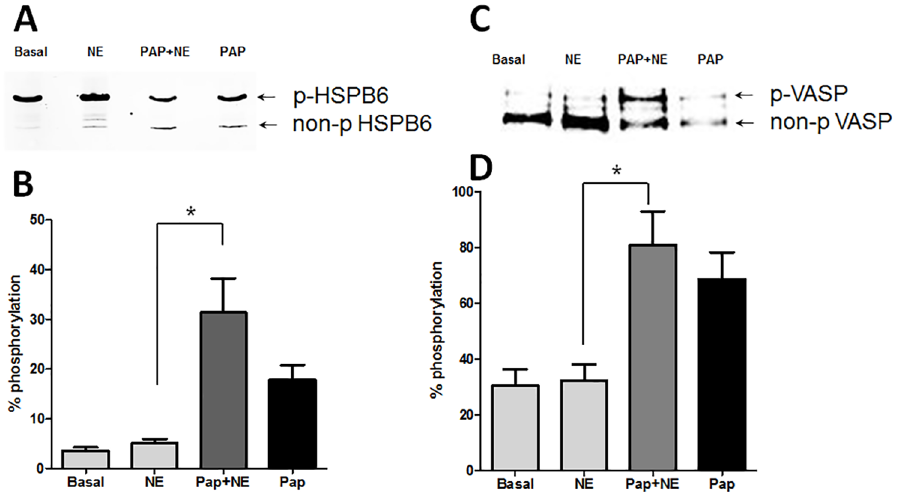
Fig 5. Preincubation with papaverine leads to increases in phosphorylation of the HSPB6 and VASP in HSV. HSV rings were suspended in a muscle bath and equilibrated in Kreb ’ s bicarbonate buffer for 2 h. Rings were untreated (Basal), treated with 1 μ M norepinephrine (NE) for 5 minutes, 1 mM papaverine (Pap) for 10 min followed by 1 μ M norepinephrine for 5 min or 1 mM papaverine (Pap) for 10 min. Tissues were snap frozen and ratios of p-HSPB6/total HSPB6 and p-VASP/total VASP to were calculated. Representative western blot for HSPB6 are shown in Panel A with the cumulative bar graph shown in Panel B. Representative blot of VASP are shown in Panel C with the cumulative bar graph in Panel D. * Significant compared to NE, N = 4, p <